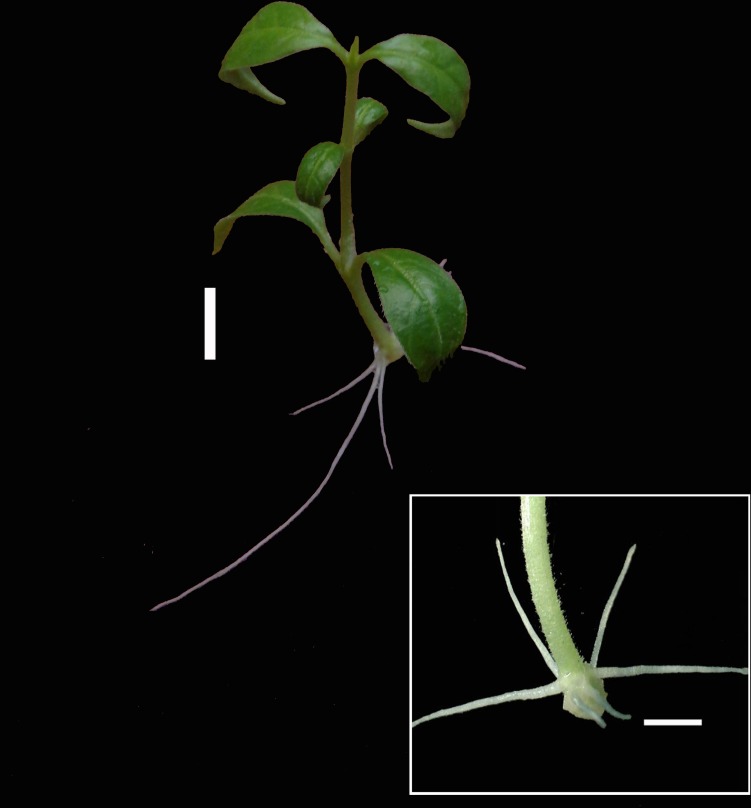
Maximum rooting observed in the shoots inoculated on MS medium supplemented with 4 μM NAA and 0.07% charcoal.